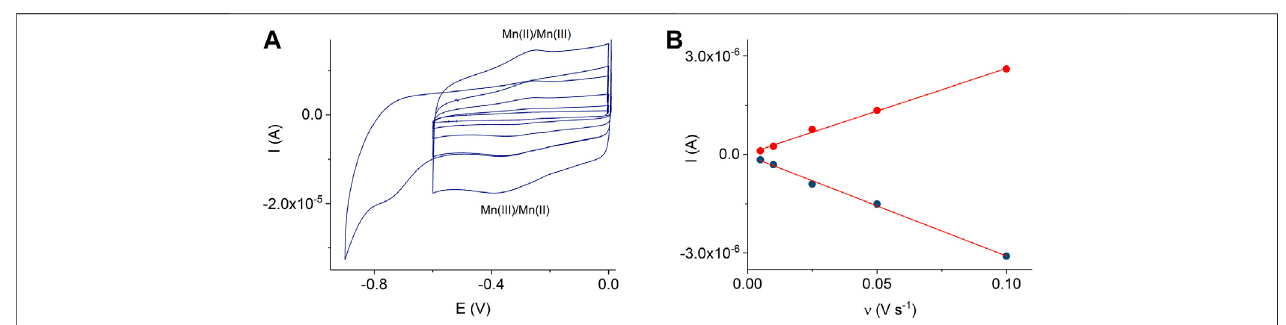
FIGURE 4 | CVs of the adsorbed MnTMPyP complex on the thin- fi lm Au/ErGO electrode recorded in a deaerated 0.1 M PB, pH 7.4, scan rate from 0.005 Vs − 1 to 0.1 Vs − 1 (A) . Dependencies of the Mn(III/II) peak currents on the scan rate, R 2 oxidation (cid:2) 0.9964 and R 2 reduction (cid:2) 0.9965 (B) .